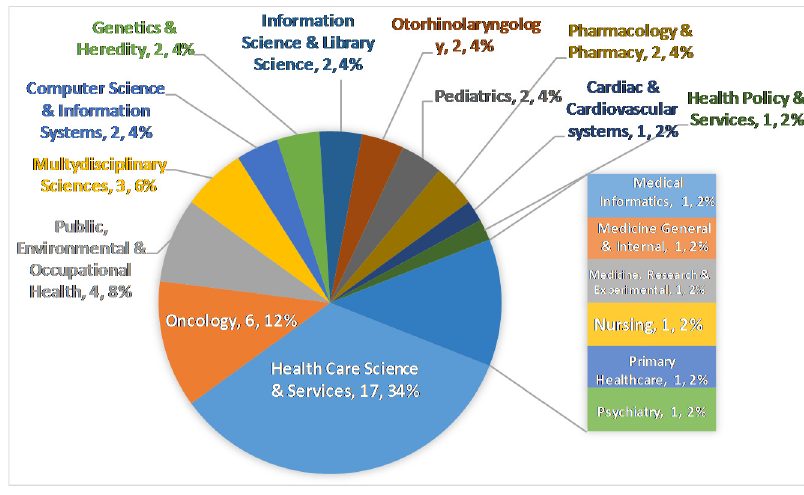
Figure 5. Main domain of articles published in journals also indexed in the Web of Science.